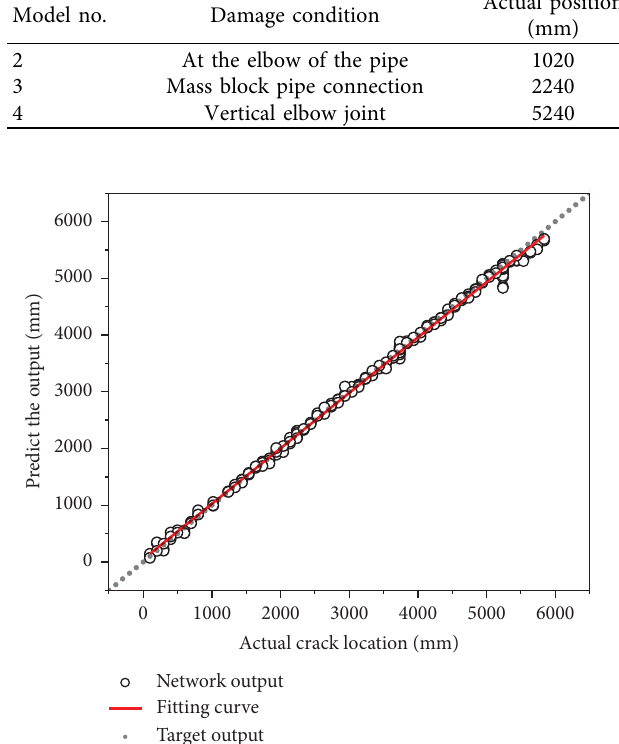
Figure 18: Comparison of the original BP neural network model predictions and actual results.